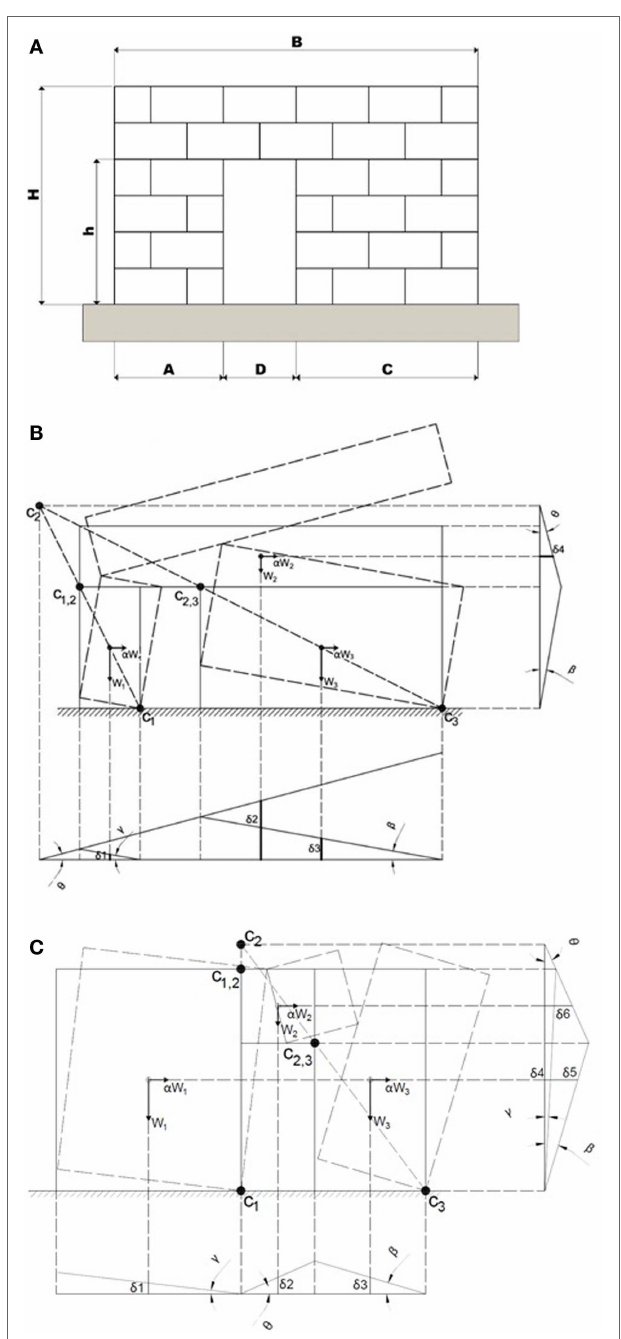
FIGURE 7 | (A) Configuration of a gabion wall with a door opening. (B) Location of hinges for the first selected mechanism. (C) Location of hinges for the second selected mechanism.